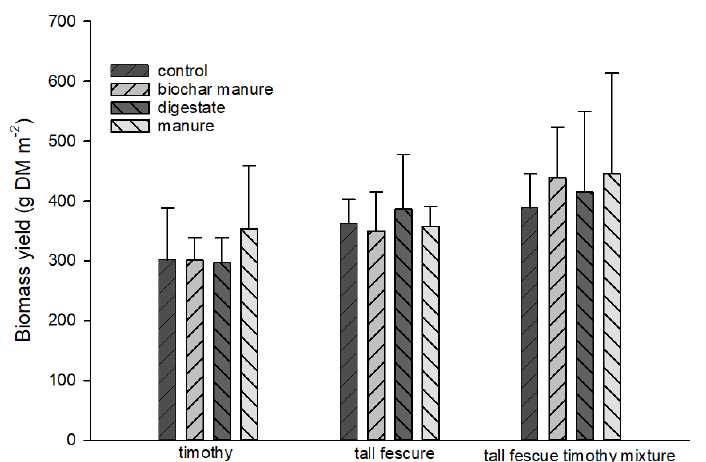
Fig. 4. Seasonal biomass yield of timothy, tall fescue and a timothy-tall fescue mixture in the four treatments at Skierniewice, Poland, in 2019. Error bars indicate 95% confidence